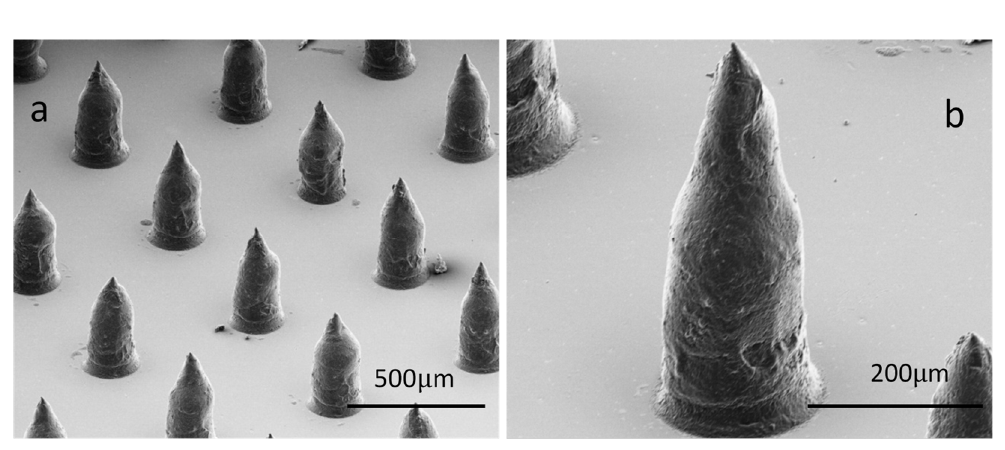
Figure 1. ( a , b ) show SEM images of different magnifications of microlithographic 3D printed microstructures on polyvinyl chloride (PVC) base